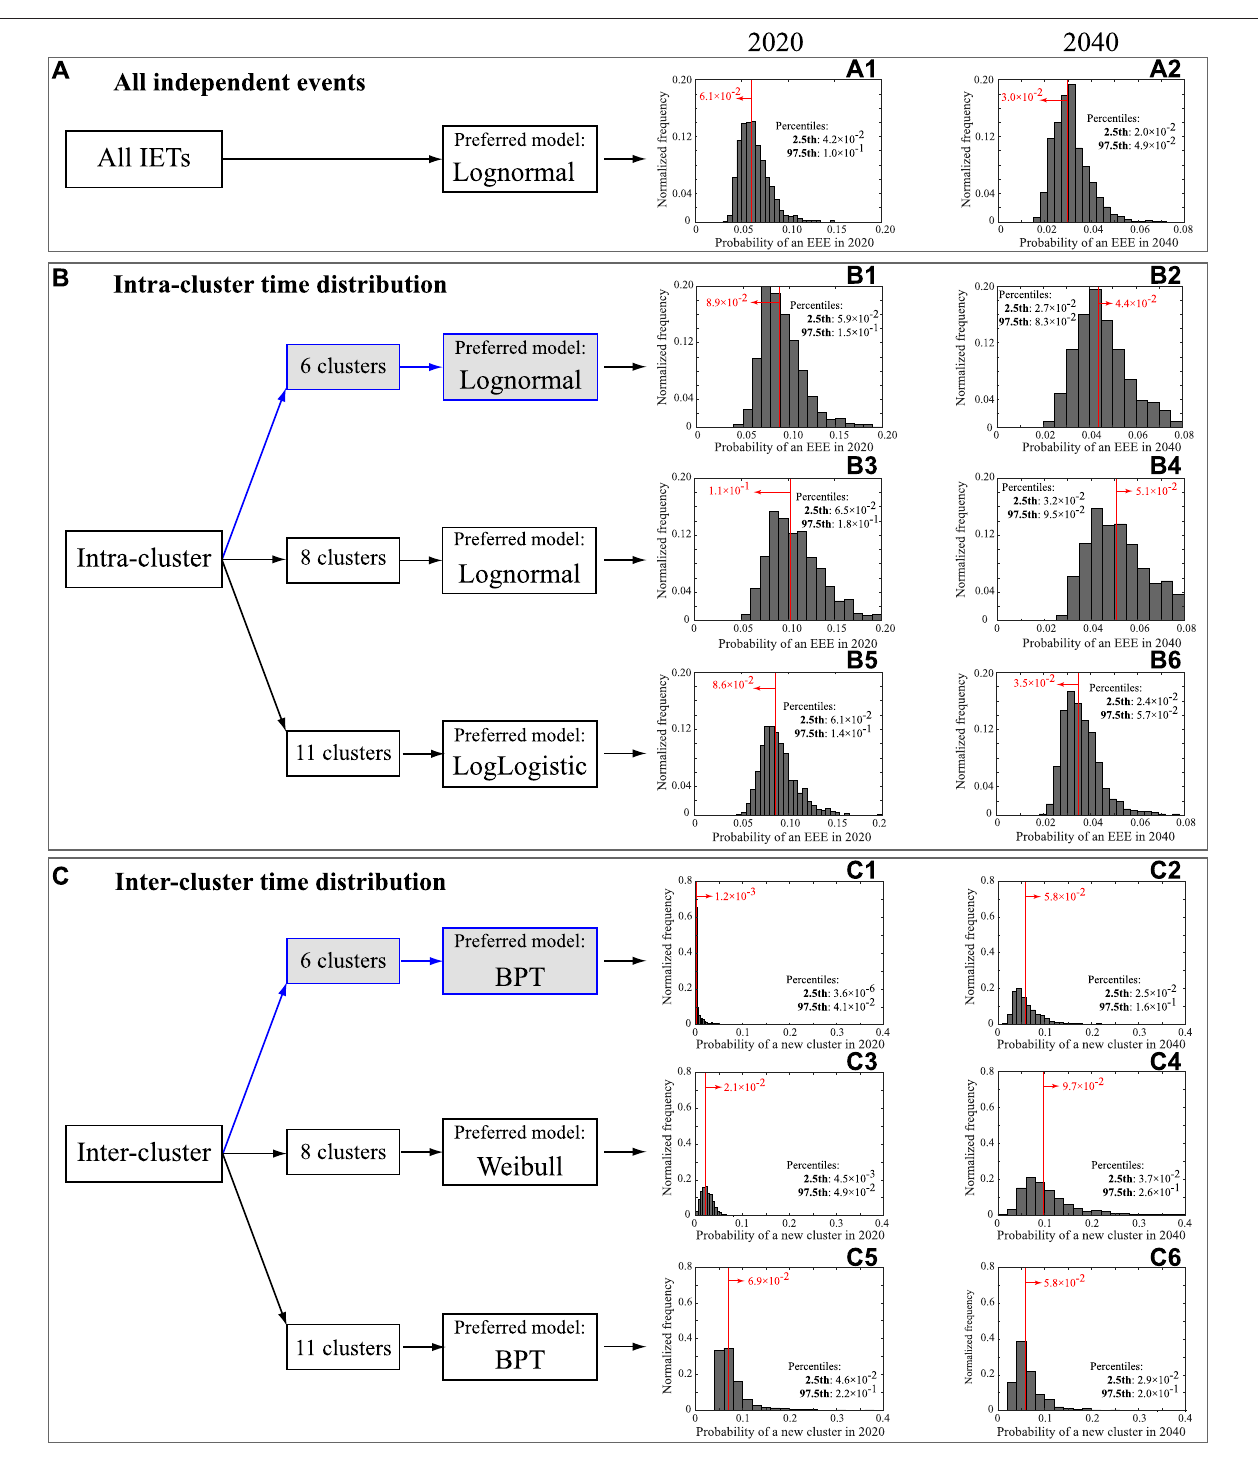
FIGURE 10 | Summary of the probability for a new EEE (Boxes A and B) or a new cluster (Box C) in the year 2020 (left-column histograms) or 2040 (right-column histograms)givennonewexplosiveeventafterthe2007one.ThethreeBoxessummarizethedifferentdataanalyzed(allIETstogether,intra-clusterIETsandinter-cluster time intervals, respectively in A, B and C). For the intra- and inter-cluster models, we provide the preferred model selected by AIC (see also Tables 3 and 4 ) when considering different cluster partitions (our preferred partition on 6 clusters is highlighted in gray). The histograms in panels (A1) to (C6) have been obtained by sampling 1,000 times the preferred-model parameters within their uncertainty range (considering covariance when the parameters are more than one) and thus calculating1,000valuesfortheprobability.Inredwegivetheprobabilityresultingfromthebest- fi tmodelparameters,andineachpanelwealsogivethe2.5thand97. fi fth percentiles of the 1,000 values to show the 95% con fi dence interval.